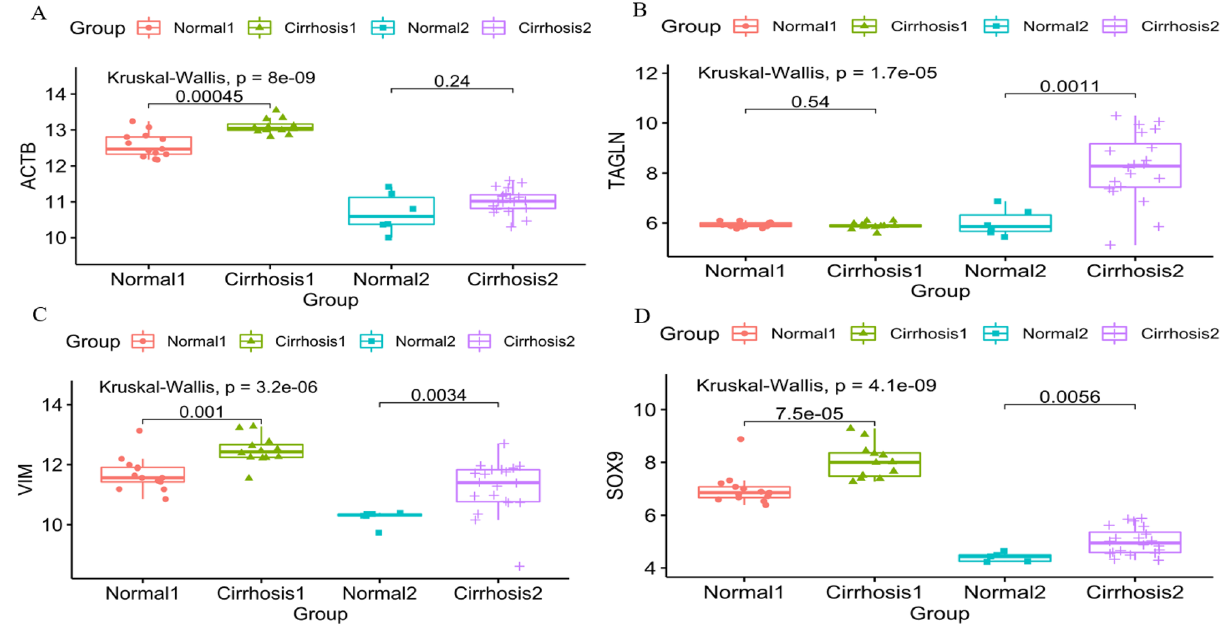
Figure 5. Expression analysis of hub DEGs between normal and cirrhosis samples from two datasets. ( A ) The expression pattern of ACTB in normal and cirrhosis samples from GSE89377 and GSE139602. ( B ) The expression pattern of TAGLN in normal and cirrhosis samples from GSE89377 and GSE139602. ( C ) The expression pattern of VIM in normal and cirrhosis samples from GSE89377 and GSE139602. ( D ) The expression pattern of SOX9 in normal and cirrhosis samples from GSE89377 and GSE139602.